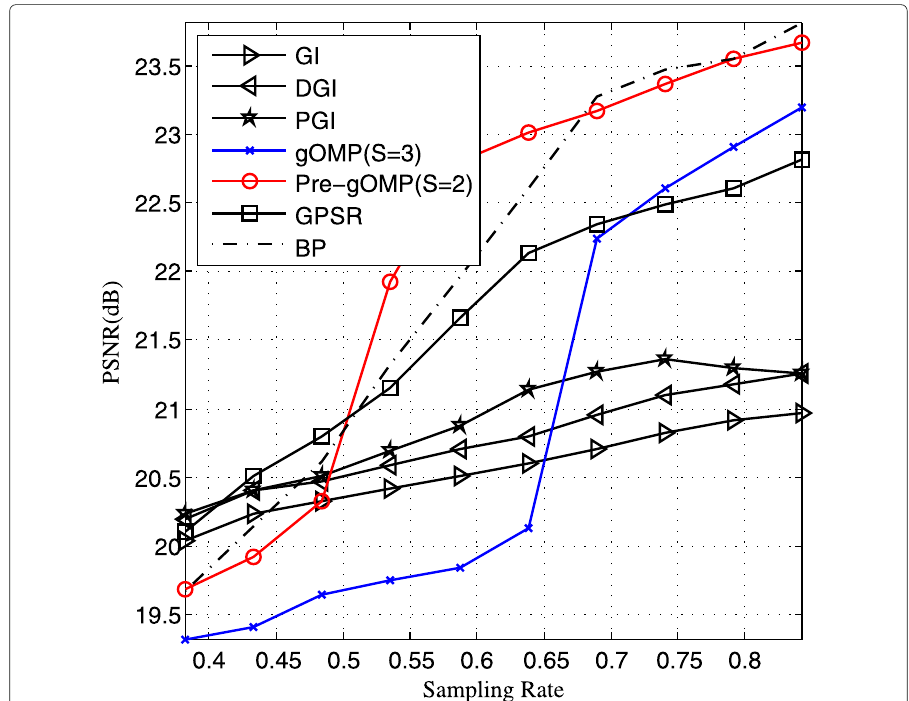
Fig. 5 The reconstruction performance as a function of the sampling rate is shown. Different reconstruction algorithms are compared